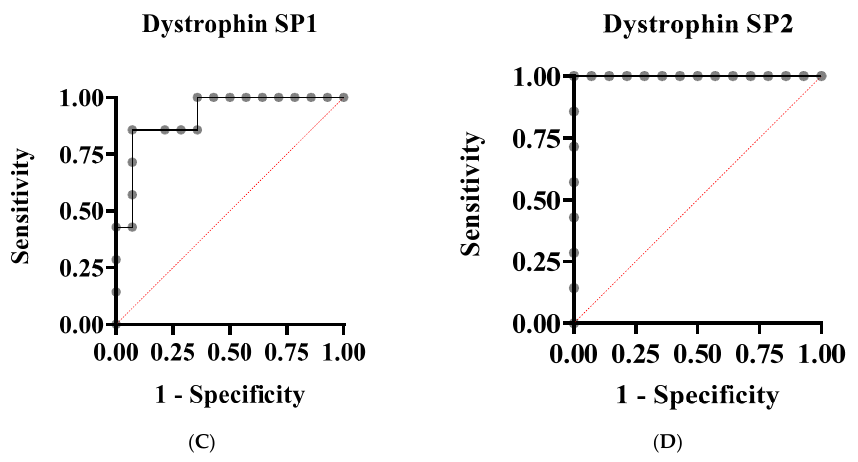
Figure 2. Dystrophin protein level in dried blood spot (DBS). The dystrophin protein level in DMD patients and healthy controls (Ctrl) was based on ( A ) dystrophin SP1 and ( B ) dystrophin SP2. The sensitivity and selectivity of CF based on these signature peptides were evaluated using ( C ) ROC curve for dystrophin SP1 with AUC 0.9184 (99% CI, p -value 0.0022) and ( D ) dystrophin SP2 with AUC 1.0 (99% CI, p -value 0.0001). The dashed red lines represent the random classifiers (x = y), above which an instance is classified as positive, and below which, it is negative. * p < 0.05, **** p < 0.0001.